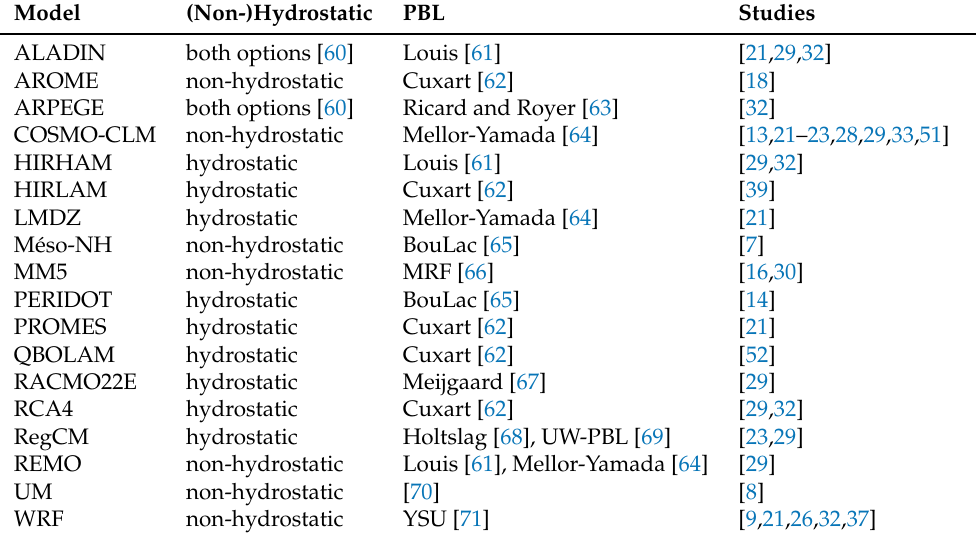
Table 1. Properties of the RCMs (atmosphere component) included in the